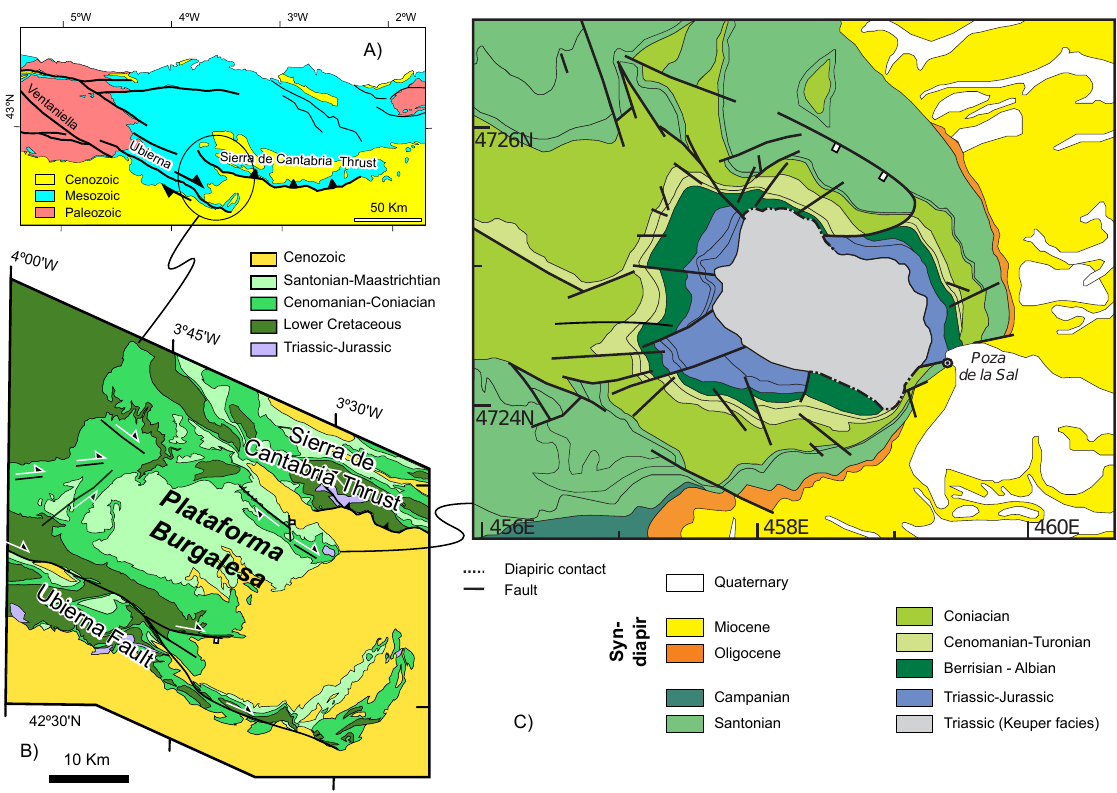
Fig. 3. Geological maps. (a) Western Pyrenean Belt. (b) Southern portion of the Cantabrian Mountains. (c) Poza de la Sal Diapir. Create a new file and define fields Edit the dataset and, eventually, In the 3D view mouse right-click to add a new datum add new records or a set of images in the selected position